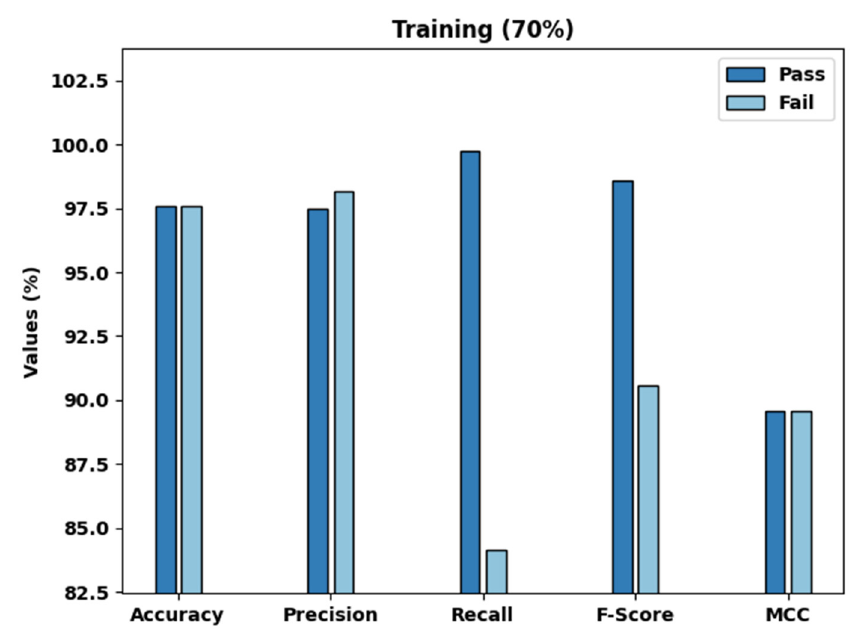
Figure 5. Result analysis of FSSML-EDM technique on 70% of training dataset.